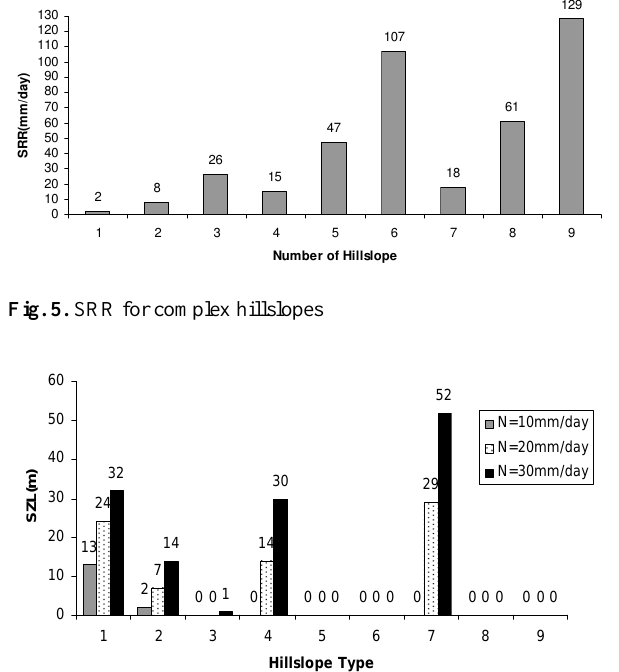
slopes compared to the convex ones. The